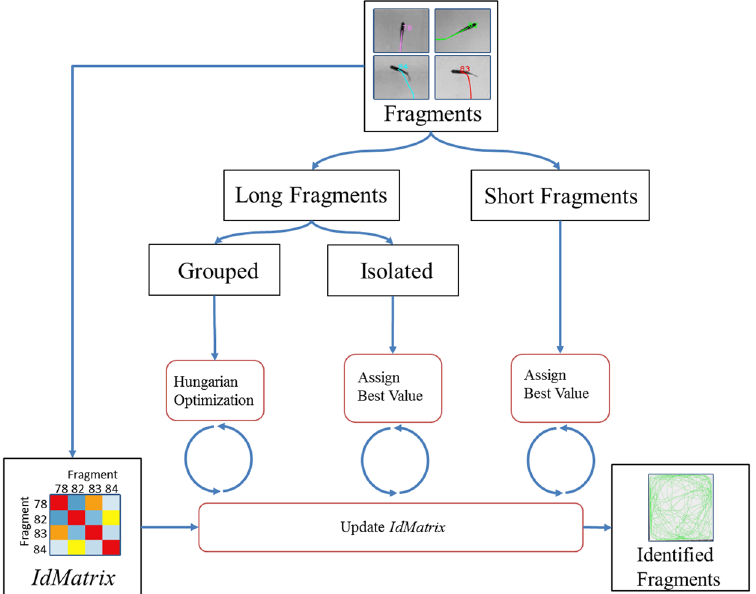
Figure 3. ToxId workflow. The matrix idMatrix contains the similarity between every two trajectory fragments. The fragments are divided between short and long according to the number of samples they contain. The assignment algorithm first uses a Hungarian optimization to assign groups of long fragments where all individuals are present. The remaining fragments are assigned one by one from higher to lower